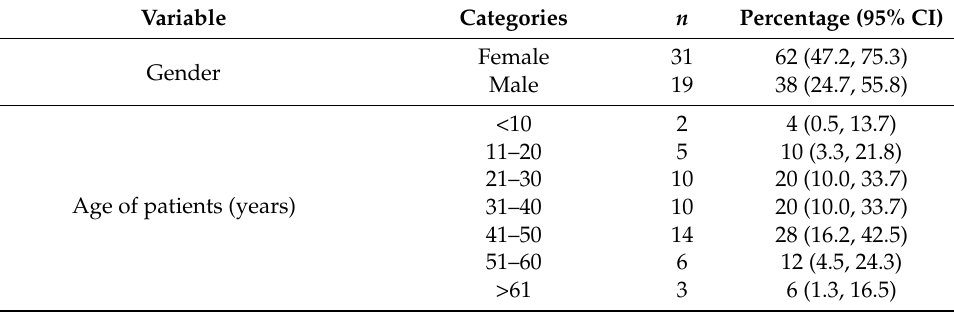
Table 2. Descriptive characteristics of the enrolled participants ( n =